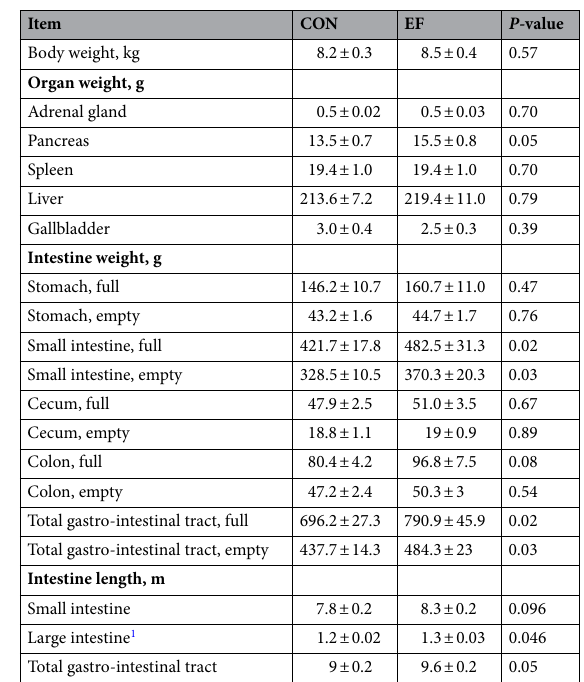
Table 1. Intestinal weights of early-fed (EF) and control (CON) piglets at weaning (d29), mean ± SEM. P -values are based on linear mixed model using body weight at sacrifice as